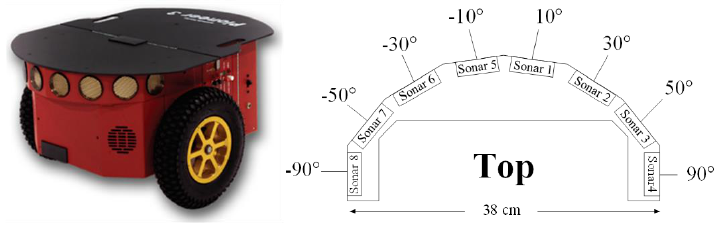
Figure 1. Architecture of the proposed FLC_R-IDS for mobile robot.